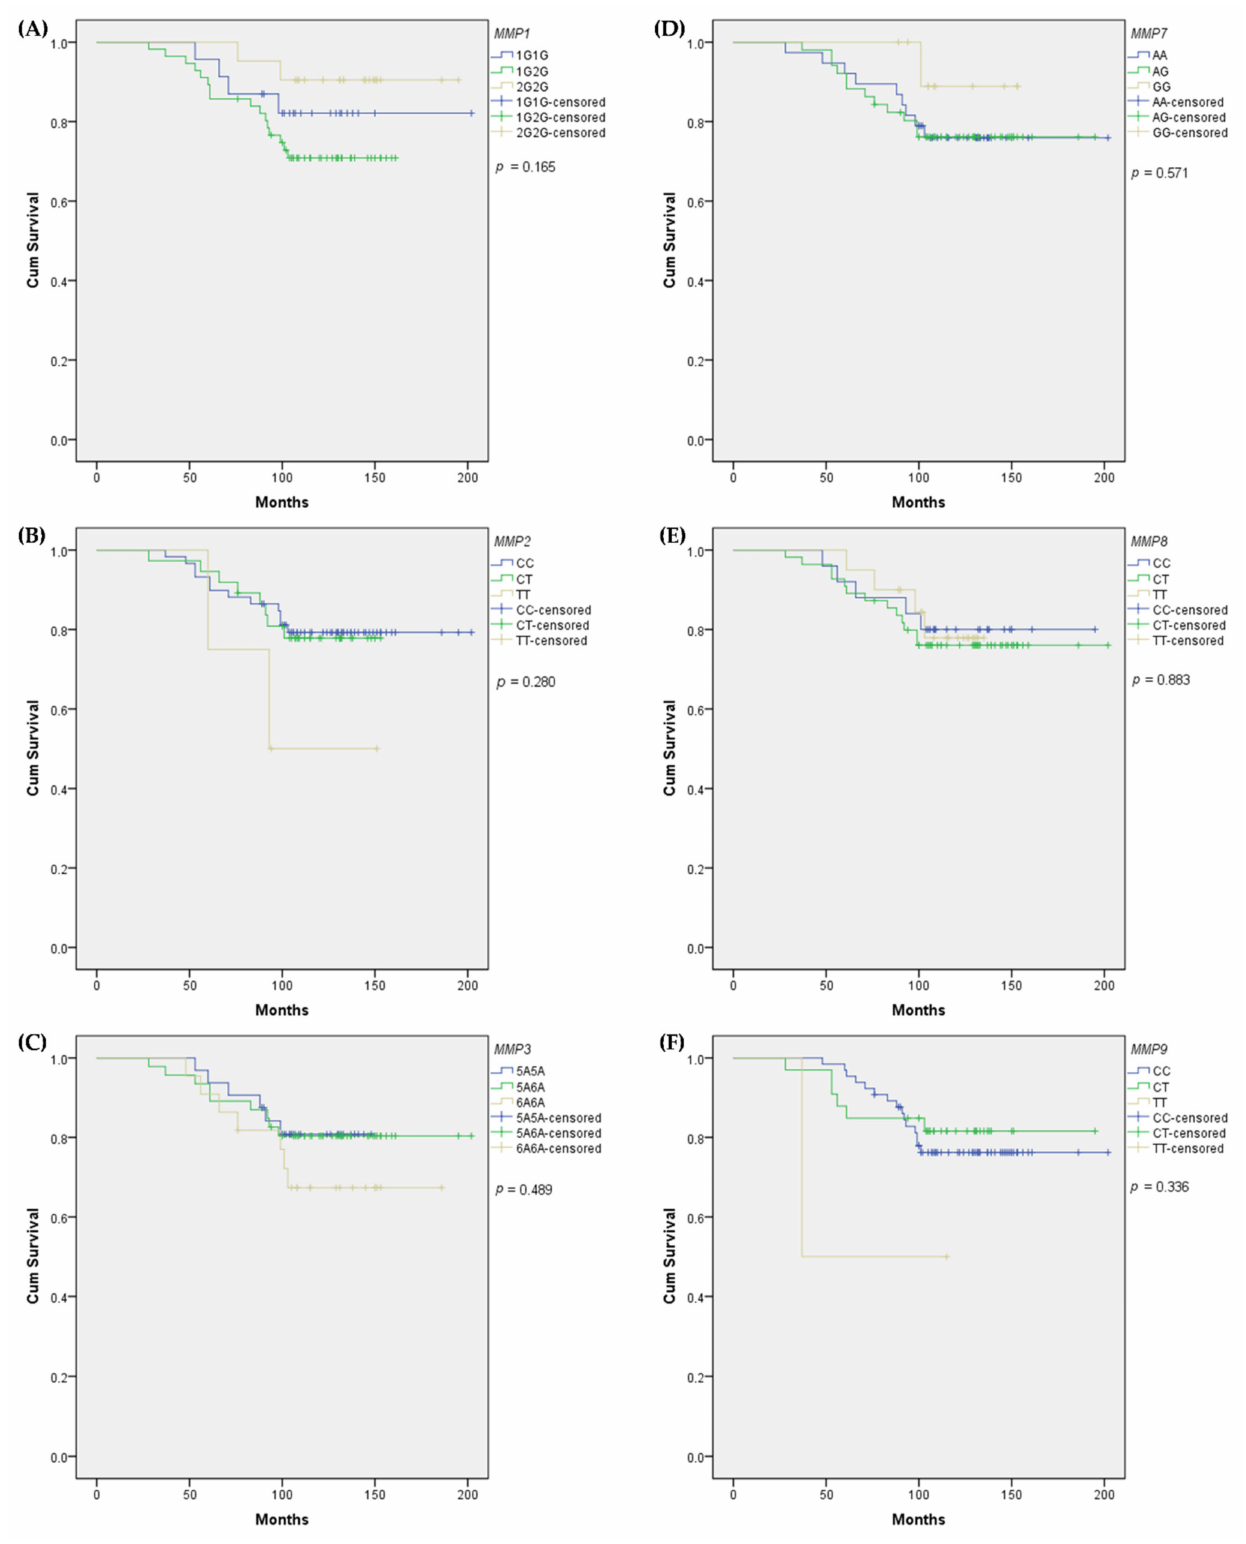
Figure 1. Kaplan–Meier estimates of overall survival: ( A ) MMP1 rs1799750, ( B ) MMP2